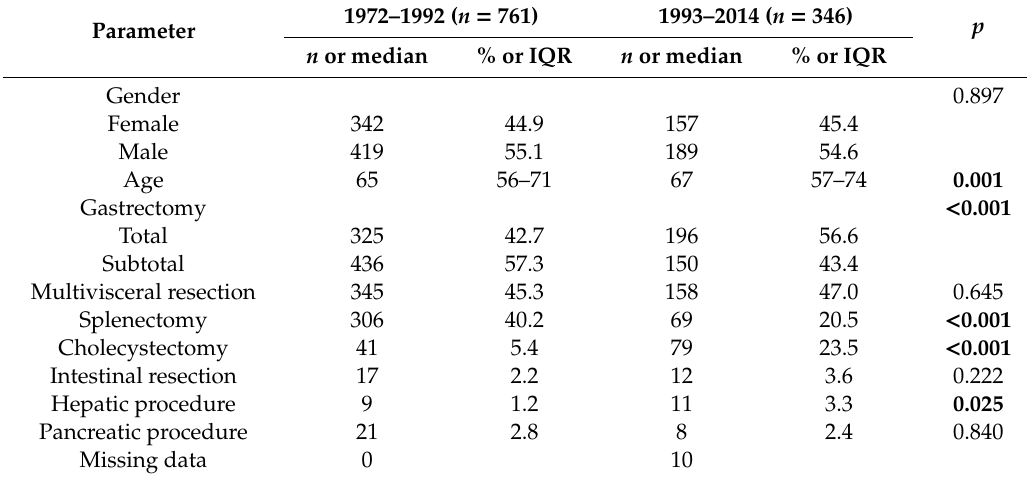
Table 1. Patient and procedure characteristics.